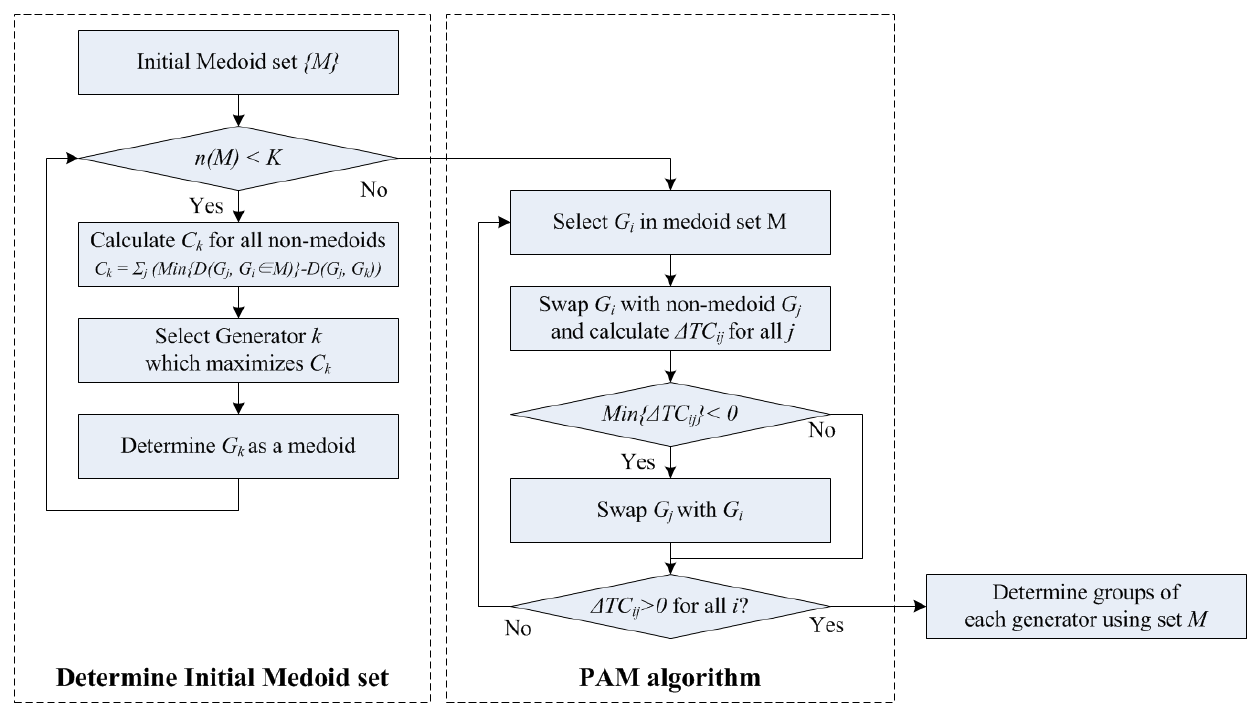
Figure 2. Flow chart of the proposed